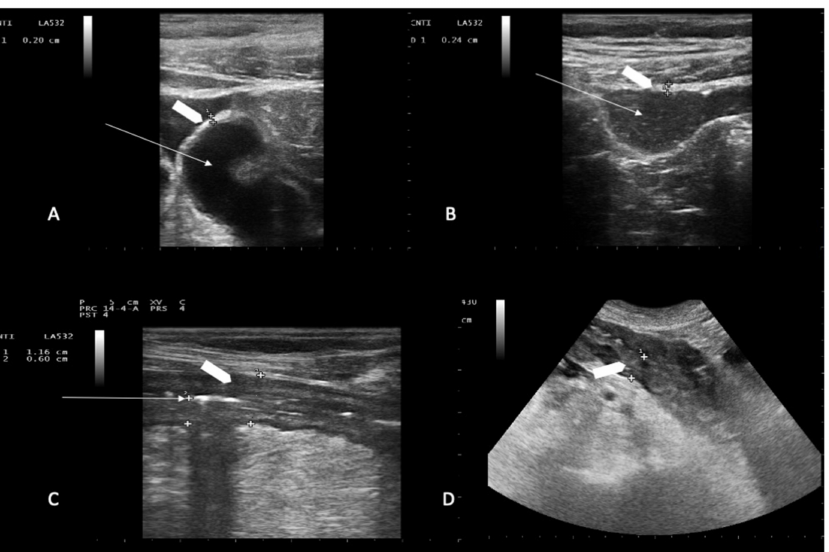
Figure 1. Representative ultrasound imaging of ileum loops. Chemotherapy-induced diarrhea: ileum loops filled with liquid (panel A ) and mixed solid/liquid material (panel B ). White arrows indicate the lumen; white arrowhead indicates normal bowel wall thickness (2.0 mm in panel A , and 2.4 mm in panel B ). Neutropenic enterocolitis involving the terminal ileum loop and descending colon: white arrow in C shows compressed lumen (panel C ); white arrowheads show bowel wall thickness (6.0 mm in panel C , and 13 mm in panel D ). Bowel wall layers are recognizable in (panel C ) while boundaries are poorly defined in (panel D